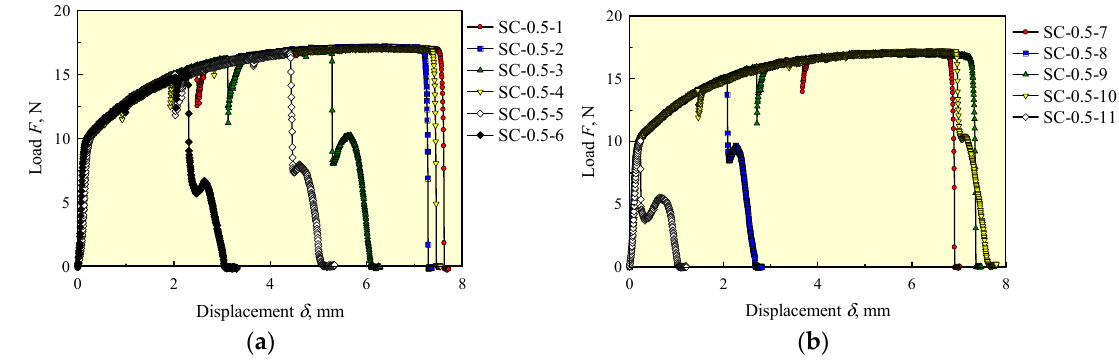
( b ) Figure 5. Load-displacement diagrams: ( a ) Specimens SC-0.5-1 to 6; ( b ) Specimens SC-0.5-7 to 11.